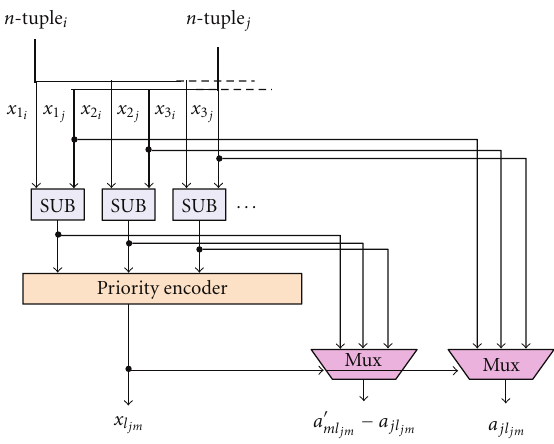
Figure 9: Computation of the terms of a binomial for (3) from a pair of n -tuples.